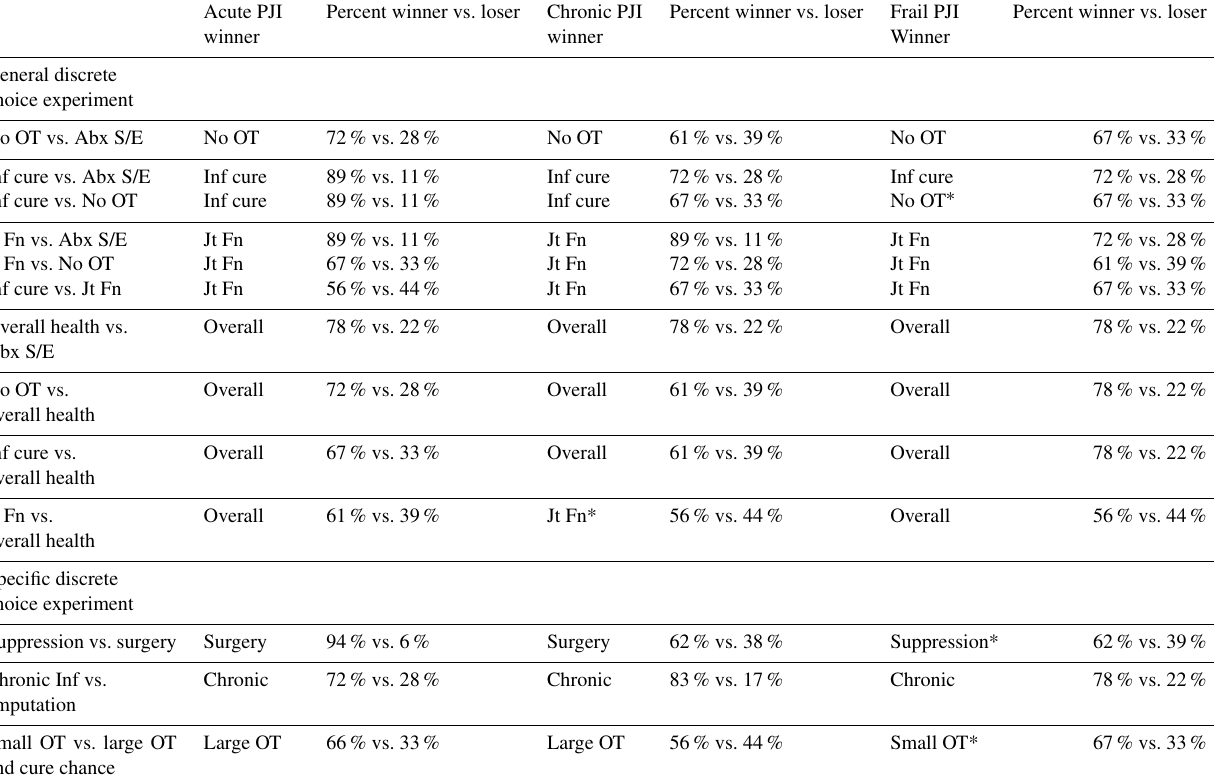
Figure 1. Proposed consensus DOOR for PJI. Joint function was defined as good for knees, with the Oxford Knee Score ≥ 32 . 5, and for hips, with the Oxford Hip Score ≥ 37 . 5 (Hamilton et al., 2018). Infection cure was defined by the international consensus criteria (Diaz-Ledezma et al., 2013). The overall health score, using the 12-item short-form health survey (SF-12) with a cut-off for a good outcome of ≥ 36 on the physical scale and ≥ 53 on the mental scale (Helwig et al., 2014). Table 2. Preferred results from discrete choice experiments in the first round of the Delphi process. Acute PJI Percent winner vs. loser Chronic PJI Percent winner vs. loser Frail PJI Percent winner vs. winner winner Winner